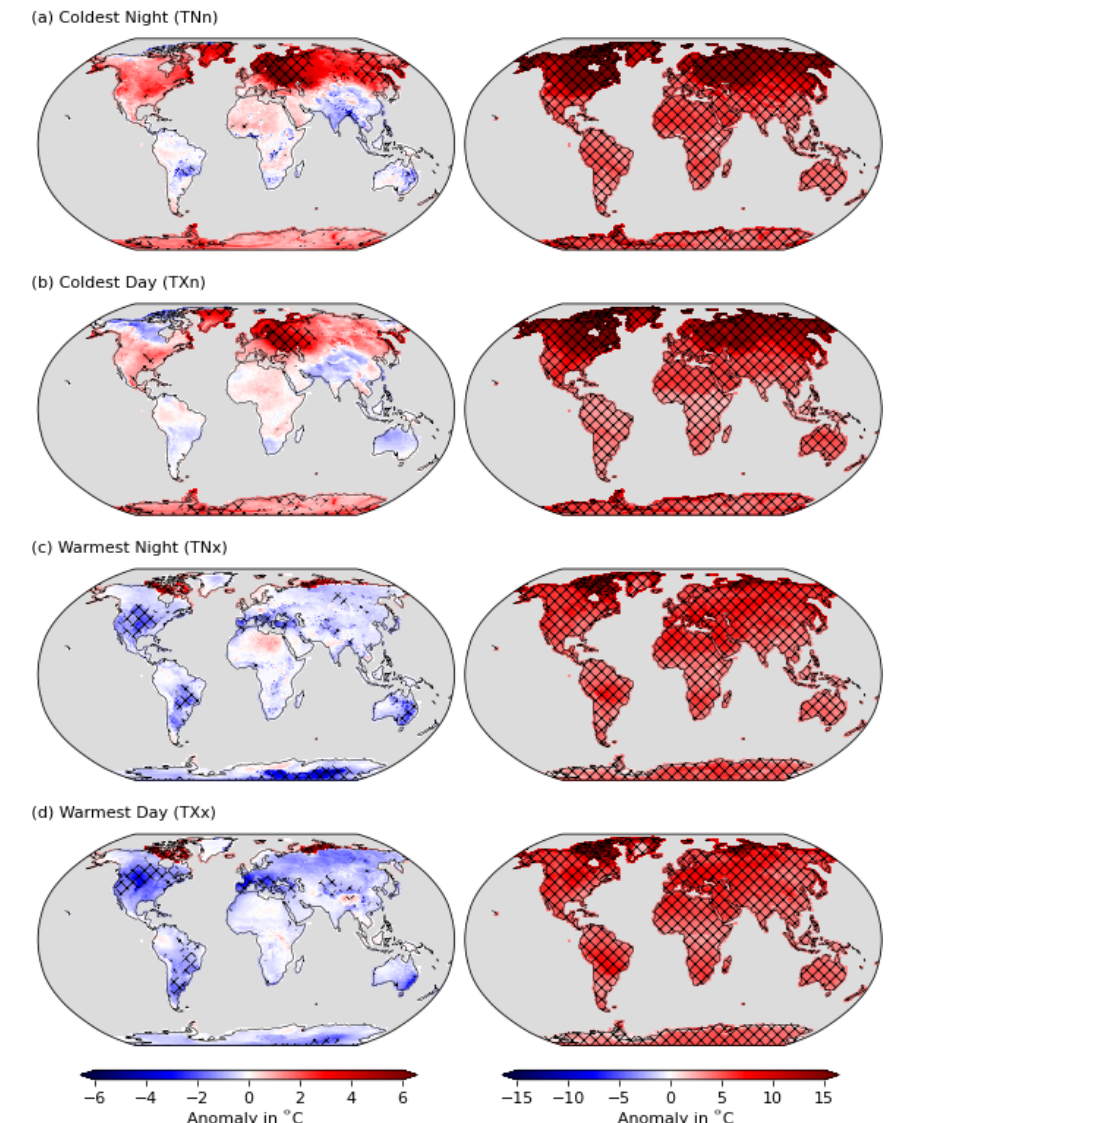
Figure 2. Projected anomalies between the GLENS EC scenario (2075–2095) and BASE (2010–2030) for the annual coldest night and day (TNn, TXn) as well as the warmest night and day (TNx, TXx) shown in the left column. Anomalies between RCP8.5 EC (2075–2095) and BASE (2010–2030) are shown in the right column. Note that the color bar is different in the right column. Hatching indicates significance at the 5% test level using the Student’s t